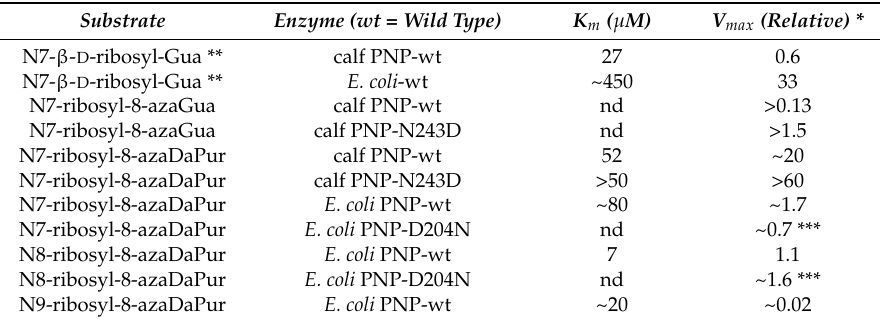
Table 2. Kinetic parameters for enzymatic phosphorolysis of selected ribosides in 25 mM phosphate buffer, pH 6.5, at 25 ˝ C, catalyzed by various forms of PNP. Errors about